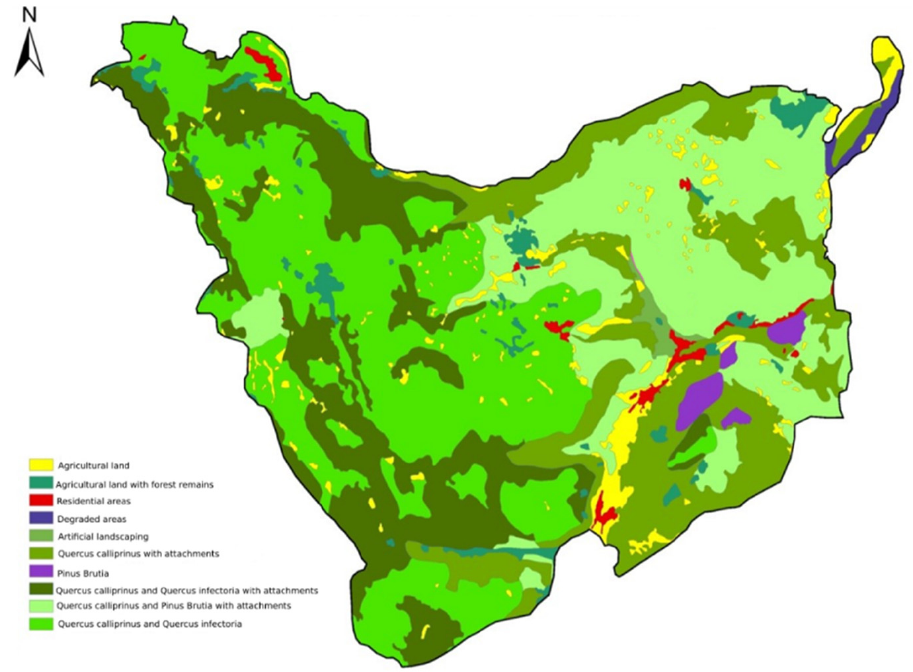
Figure 2. Land use and land cover in Abu Qubies as a unique ecological feature.